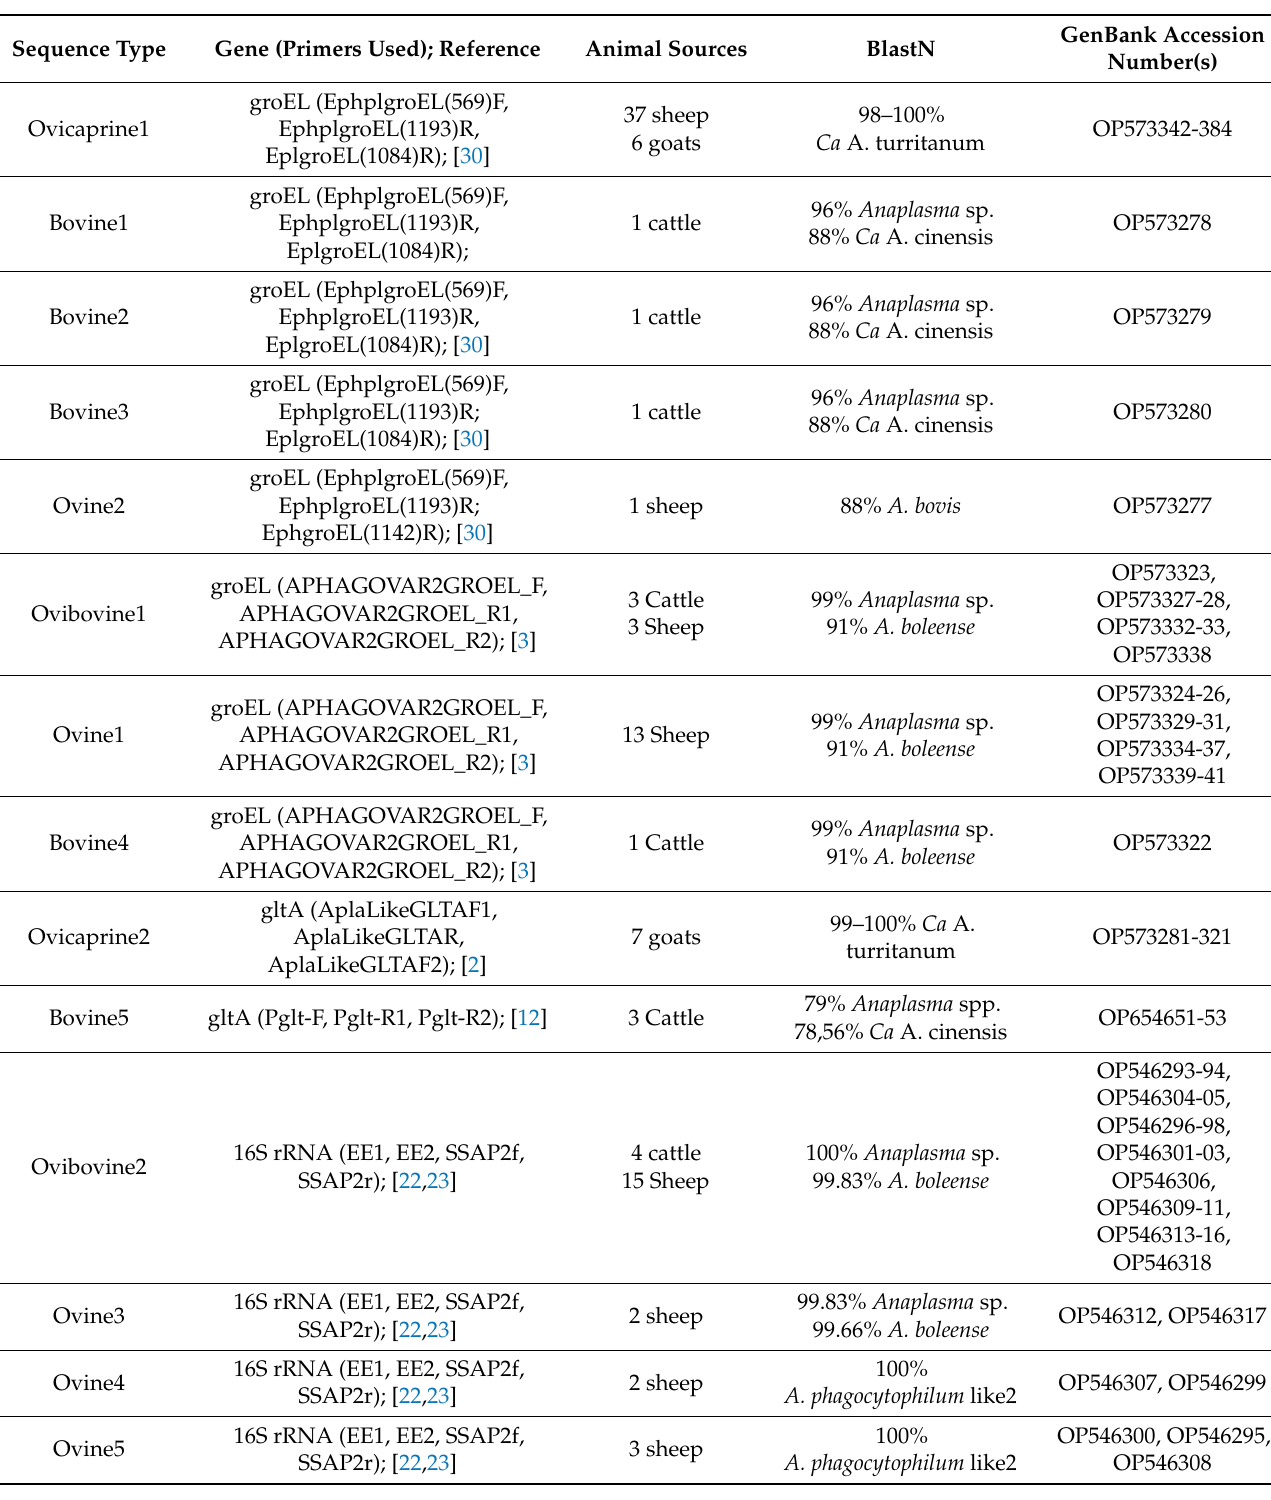
Table 3. Assignment of sequence types obtained in this study and similarity to sequences deposited in the